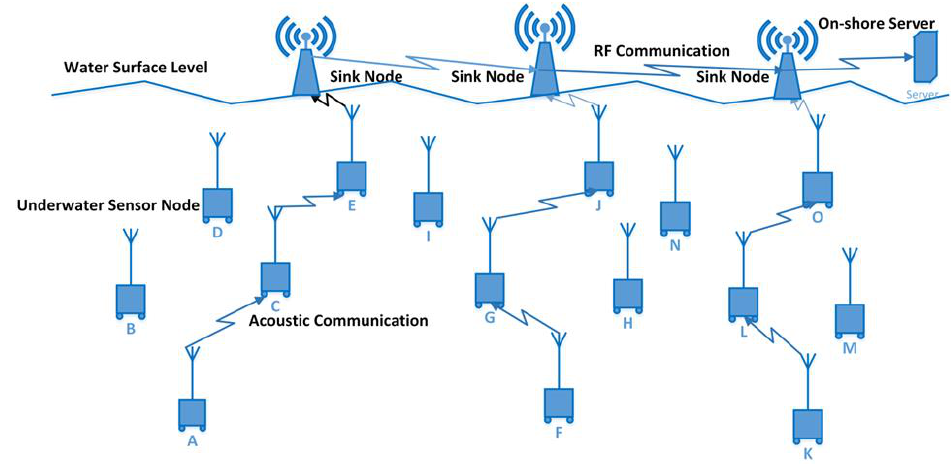
Figure 1. UWSNs Architecture.